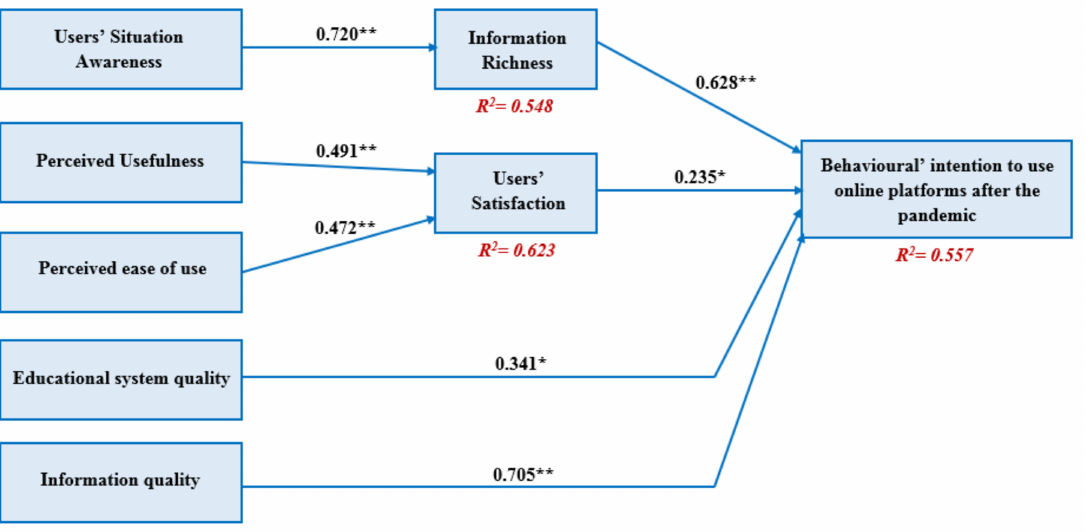
Figure 2. Path coefficient of the model (significant at ** p ≤ 0.01, * p <